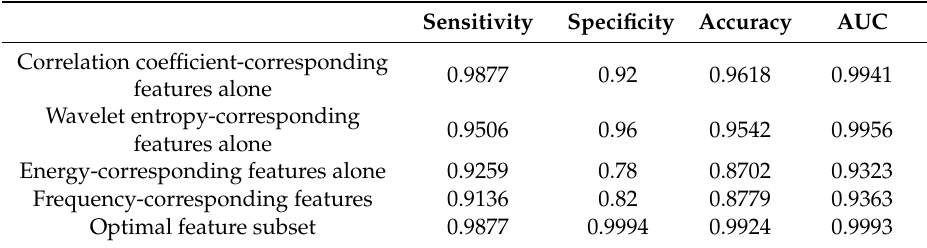
Figure 12. Comparison results of di ff erent category features in distinguishing human targets from dog targets. Table 6. Comparison results of di ff erent category features in distinguishing human targets from dog targets